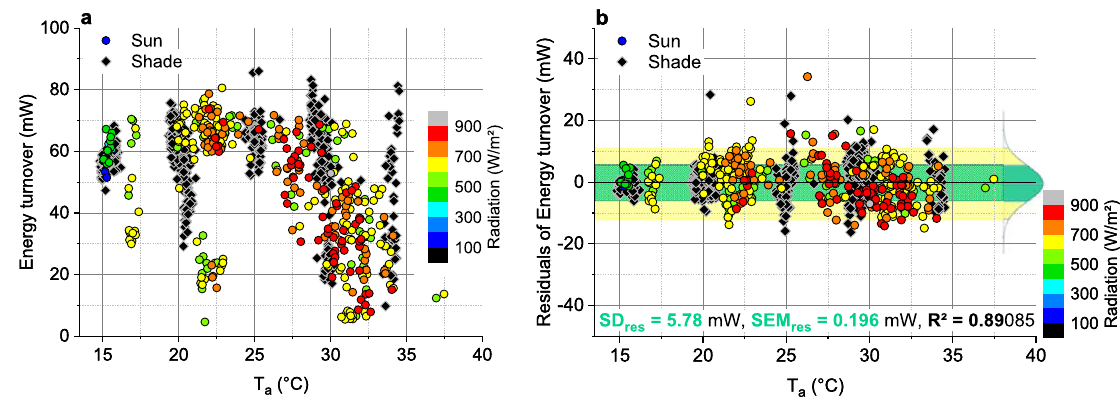
Figure 6. Energetics and model results of sucrose gathering honeybees foraging in shade (≤ 100 W m −2 ) or in sunshine (> 100 W m −2 ), in dependence on ambient air temperature (T a ). ( a ) Energy turnover; original data of bees fed 1.5 M sucrose solution in unlimited flow (from 17 ), and 0.5 M sucrose in unlimited flow or limited flow of 15 µl min −1 (from 18 ); N = 872 visits to artificial flowers; SD = 17.59 mW. ( b ) Residuals of model calculation according to the use of Eq. (13) in Eq. (6), see Table 2a for model coefficients; green bar = ± 1 SD res , light yellow bar = ± 2 SD res , R 2 = adjusted for degrees of freedom; residual standard error of mean (SEM res ) = 0.196